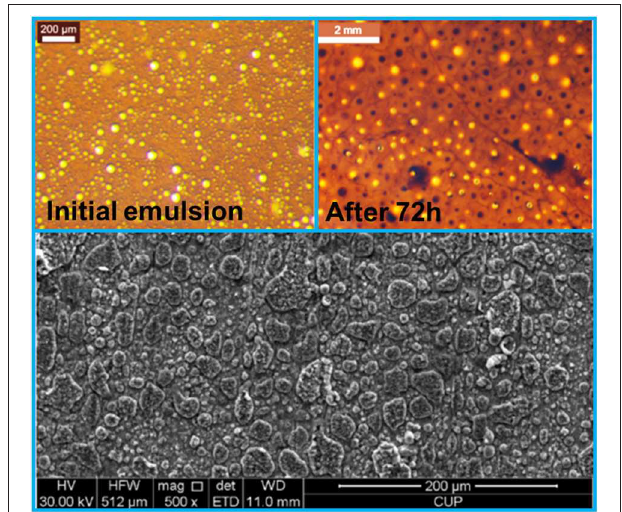
FIGURE 6 | Microscopic images of a water-in-oil emulsion with a water cut of 70 wt.% before and after corrosion test and the corrosion morphology of P110 steel surface after autoclave test for 72h at a CO 2 pressure of 10 MPa, 80 ◦ C. The initial emulsion was prepared by mixing oil and water at a stirring rate of 1,200 rpm in an emulsifier. The “after 72 h” refers to the state of the emulsion after autoclave test. The oil’s density is about 0.88 g/cm 3 ( Wang Z. L. et al., 2014) and the brine solution is similar to the CO 2 -EOR production water in Shengli oilfield ( Zhang J. et al., 2012; Wang et al., 2015). The image of emulsions was observed using a stereomicroscope (as described in Wang Z. L. et al., 2014) and the corrosion morphology was detected by a Scanning electron